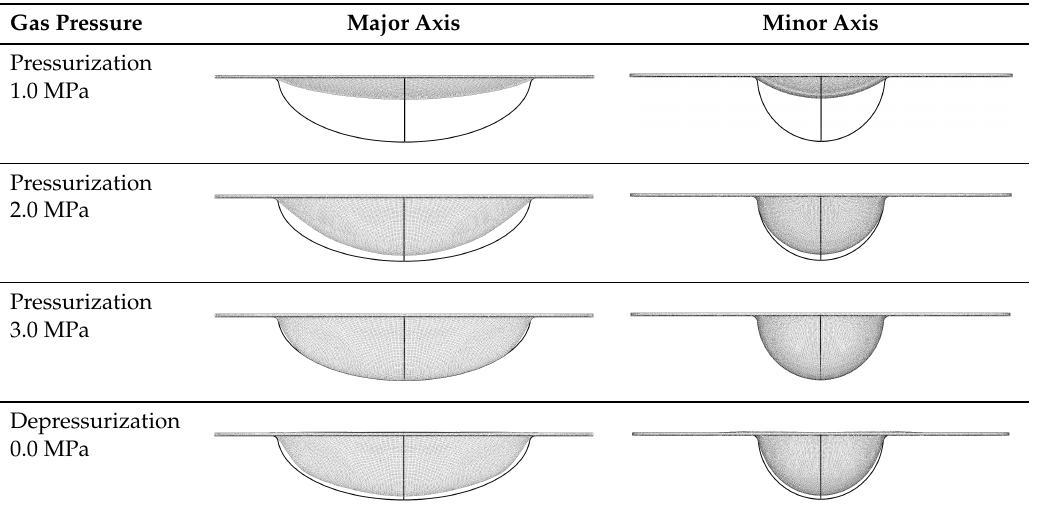
Table 3. Deformations of the polycarbonate sheet at gas pressure levels of 1.0 MPa, 2.0 MPa, and